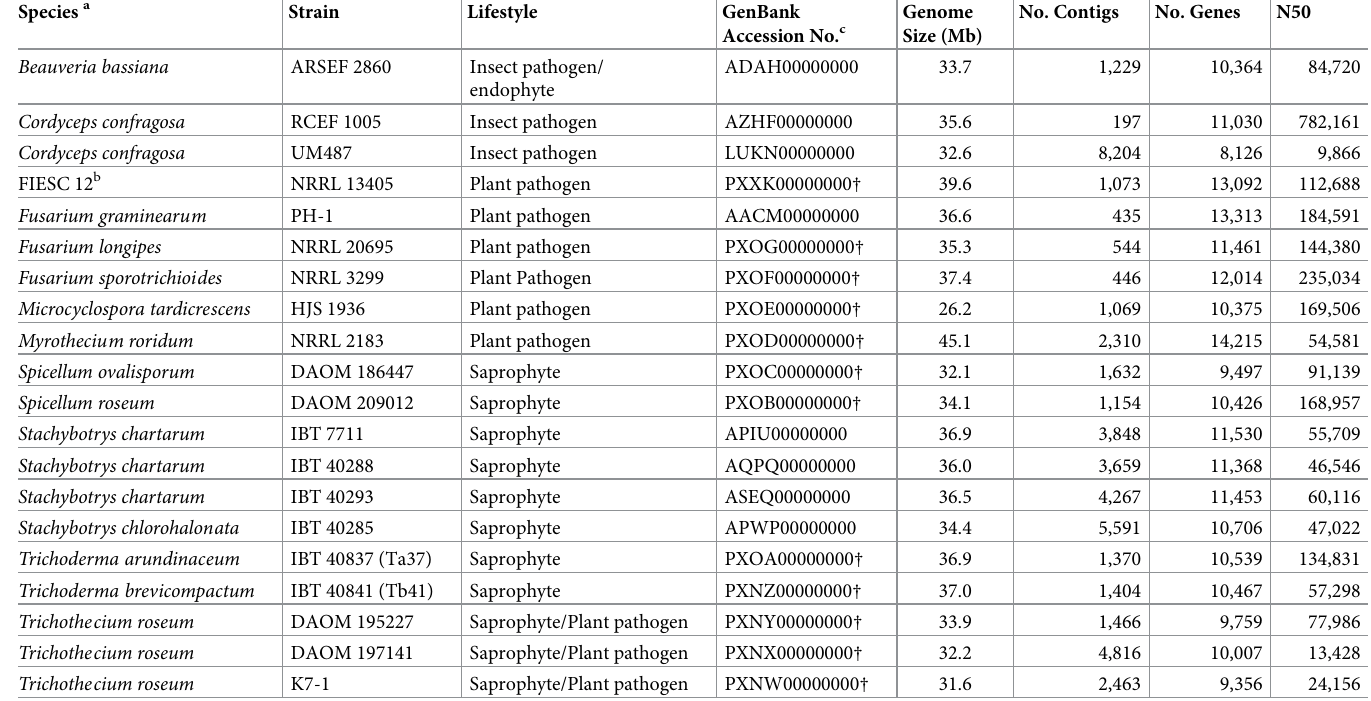
Table 2. Information on fungal strains and genome sequences examined in the current